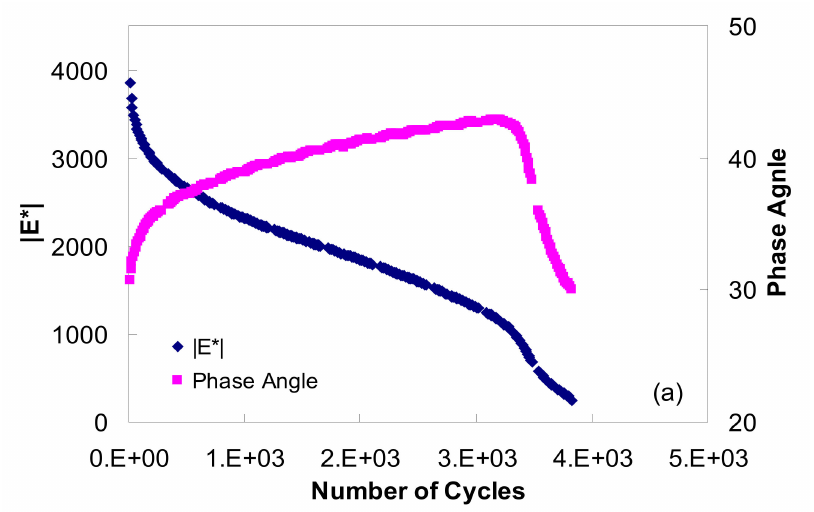
Figure 7. Curves depicting the changes in dynamic modulus and phase angles according to loading